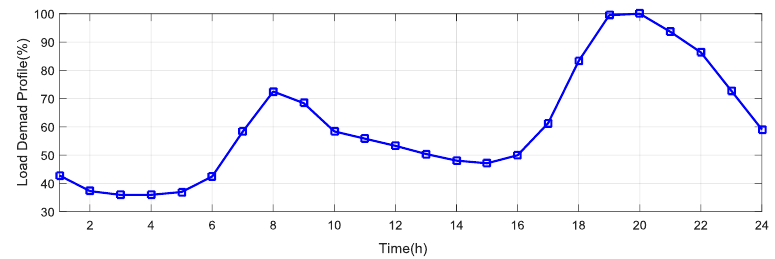
Figure 4 . 24-h Load Demand Profile. Table 1. Simulation data for WT, PV and SVC.